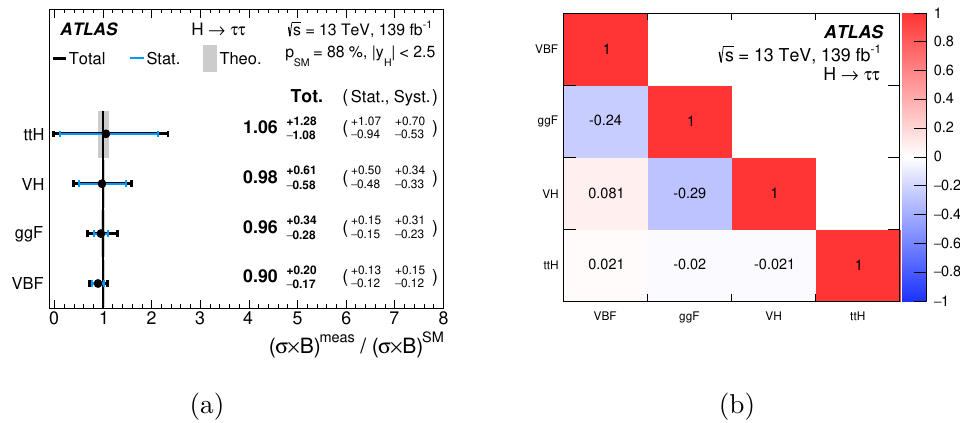
Figure 13. (a) The measured values for σ × B ( H → ττ ) relative to the SM expectations in the H four dominant production modes. The total ± 1 σ uncertainty in the measurement is indicated by the black error bars, with the individual contribution from the statistical uncertainty in blue. (b) The measured correlations between each parameter of interest in the measurement of the cross-sections per production mode. The results have been extracted performing a fit for the production mode cross-section measurements. The measured values for σ × B ( H → ττ ) along with the corresponding H correlation matrix are available in the HEPData repository